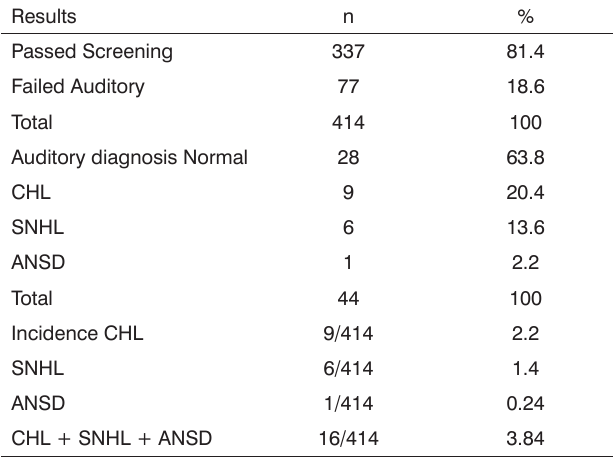
Table 4. Main study findings for the enrolled